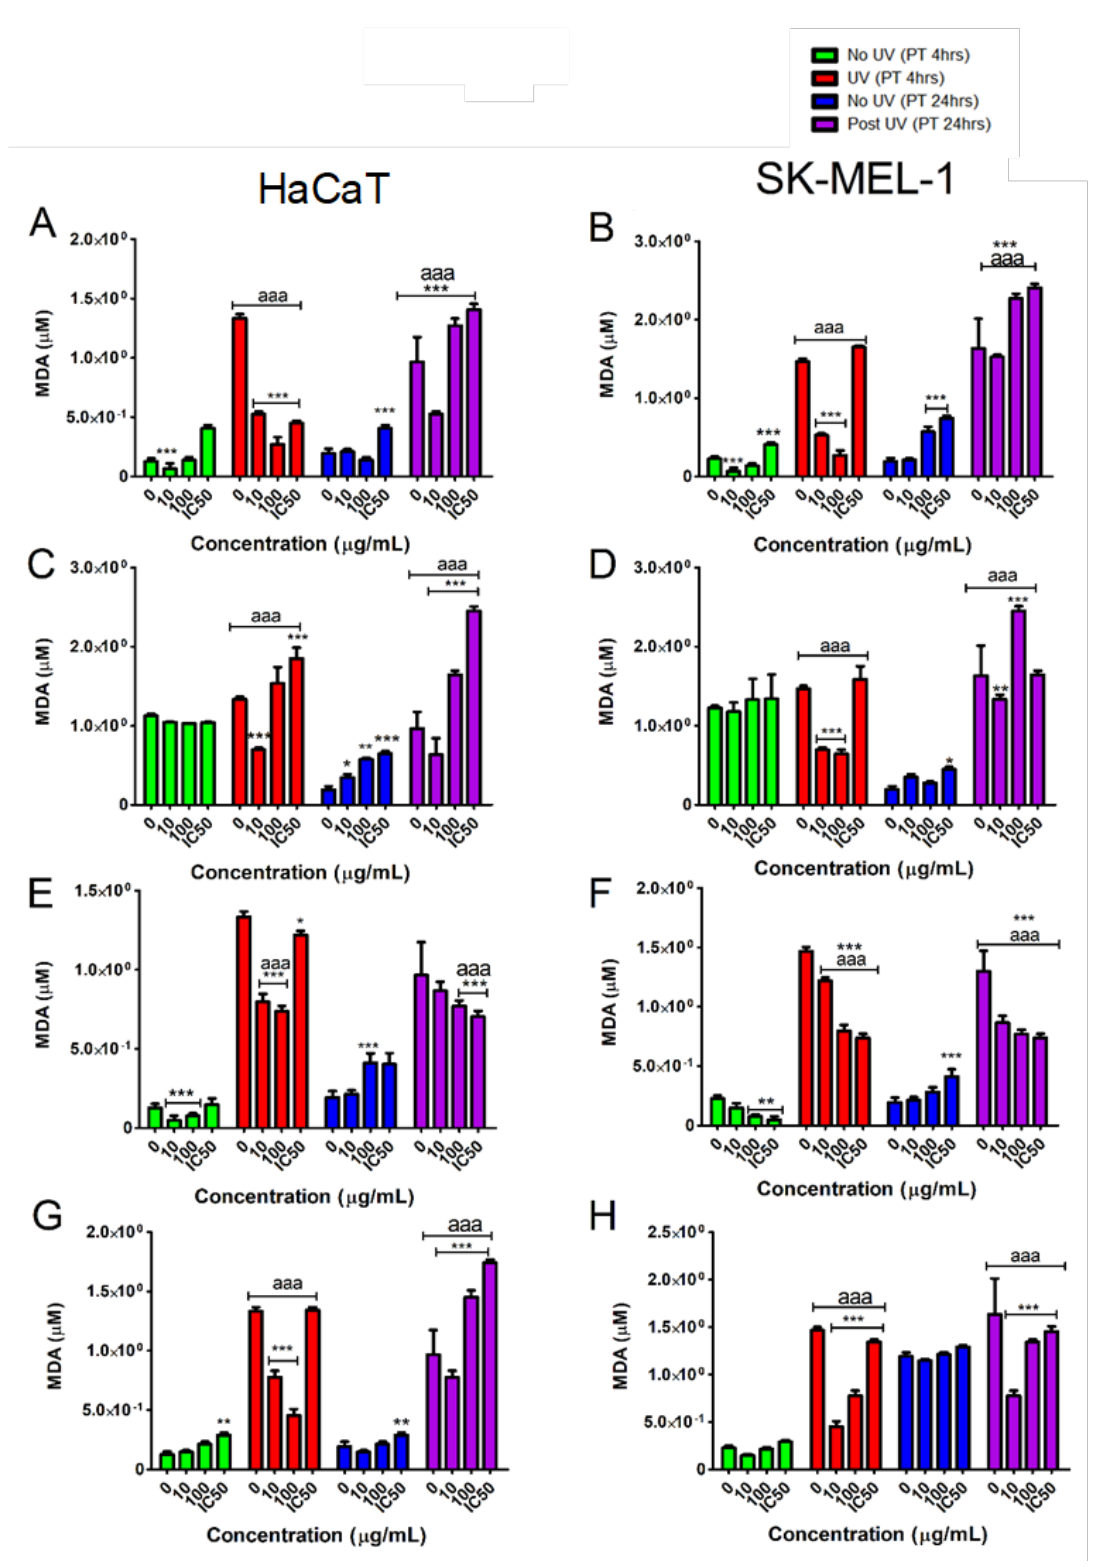
Figure 8. Protective effects of the tested samples [TE ( A , B ); compound 1 ( C , D ); compound 2 ( E , F ); compound 3 ( G , H )] against lipid peroxidation after 4- and 24-h treatment before exposure to UVB irradiation. Vertical lines indicate standard deviation. * p < 0.05, ** p < 0.01, *** p < 0.001 control vs. experimental concentrations; aaa p < 0.001 No UVB irradiation vs. UVB irradiation for experimental concentrations.